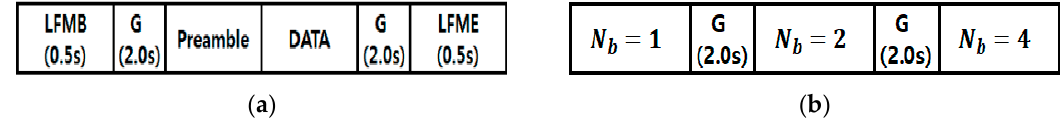
Figure 6. Transmission signal packet structure: ( a ) Individual band packet structure; ( b ) multi-band packet structure.